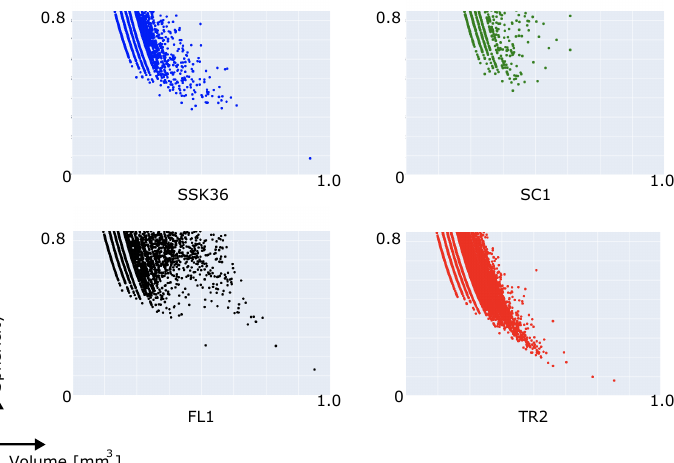
Figure 5. Results of the Blob Analysis of the vesicles-discussed in Table 2—showing the trends depicted by binary relations between the volume of each identified blob and sphericity (defined as the ratio between the diameter of the maximum inscribed sphere of each identified blob and the diameter of a sphere with the same volume as the blob). The figure is represented as a scatter plot. All the trends show a decrease in the degree of sphericity with increasing volume, indicating the tendency of vesicles to become more deformed as their size increases. On average, trends indicate a marked higher size of the vesicles in FL1 and SC1 samples being also characterised by a higher sphericity with respect to SSK36 and TR2 samples. This reflects the nature of the samples: FL1 and SC1 show a foamy texture, due to a high presence of glass and gas phases during their formation; SSK36 and TR2 are instead lava rocks featuring a highly crystalline or microcrystalline texture in which the gas phase was present in lower amounts compared to the foamy